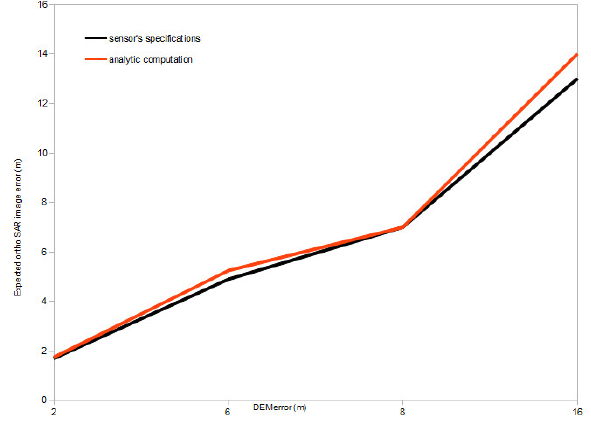
Figure 10: Expected planar error according to the sensor’s speci- fications (in black) and according to analytical equations (in